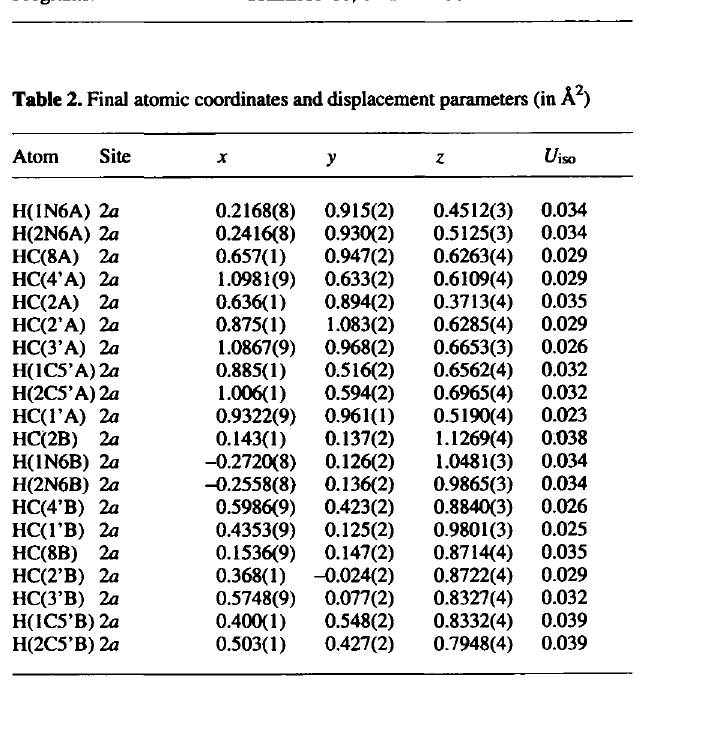
Table 2. Final atomic coordinates and displacement parameters (in